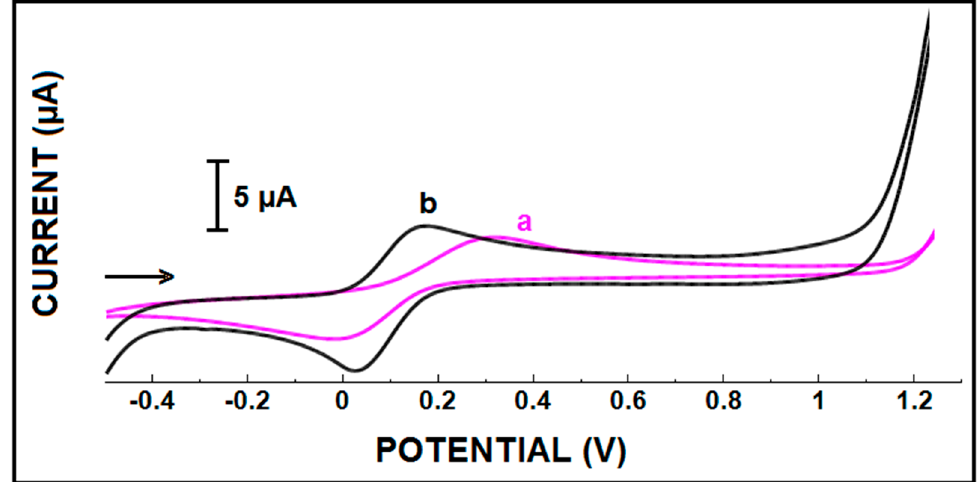
Figure 2. Cyclic voltammograms (CVs) of ( a ) SPE, ( b ) CNF-SPE in 2 mM K 4 [Fe(CN) 6 ] / K 3 [Fe(CN) 6 ] prepared in 0.1 M KCl.